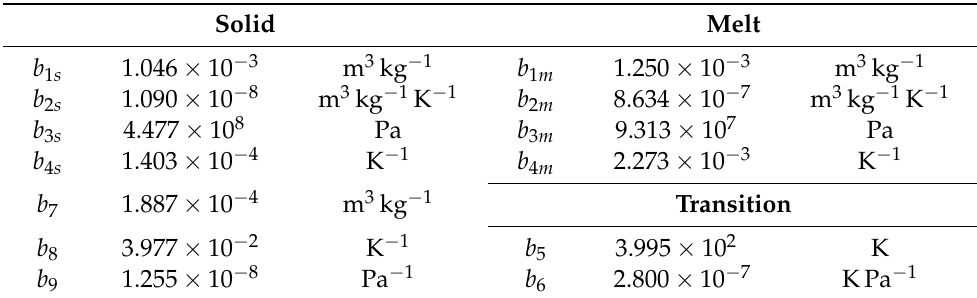
Table A2. Approximation parameters for HDPE in the solid (s), melt (m), and transition region of the two-domain pvT-model of Tait.